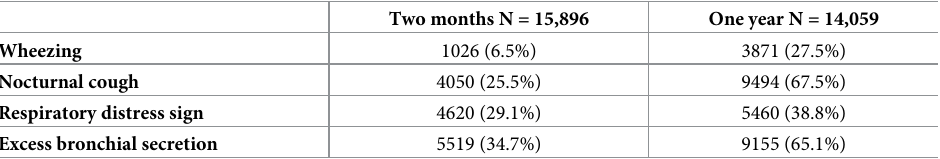
Table 1. Prevalence of wheezing and other respiratory symptoms at two months and one year in ELFE